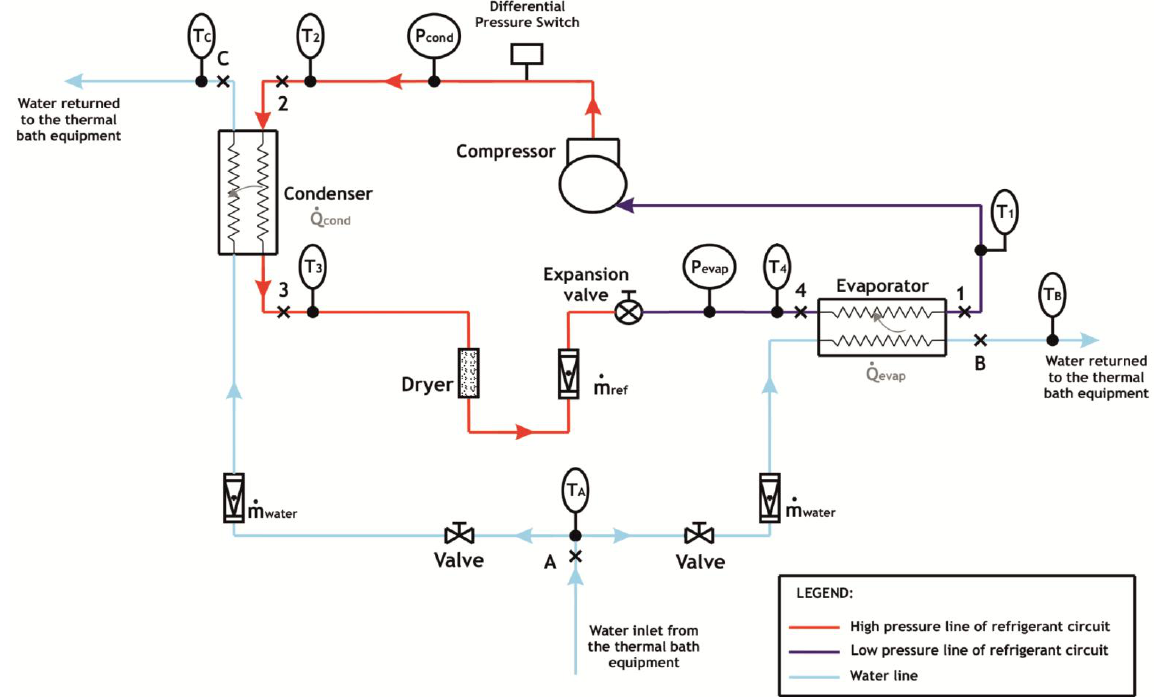
Figure 1: Simplified scheme of the experimental set-up.